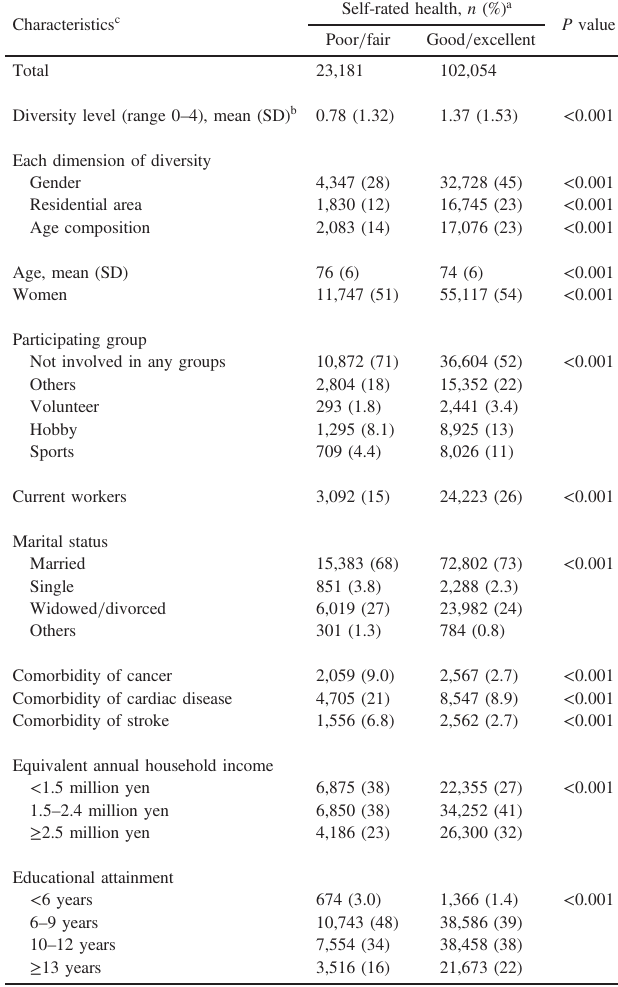
Table 1. Characteristics of participants who had better self-rated health and who did not have better self-rated health Characteristics